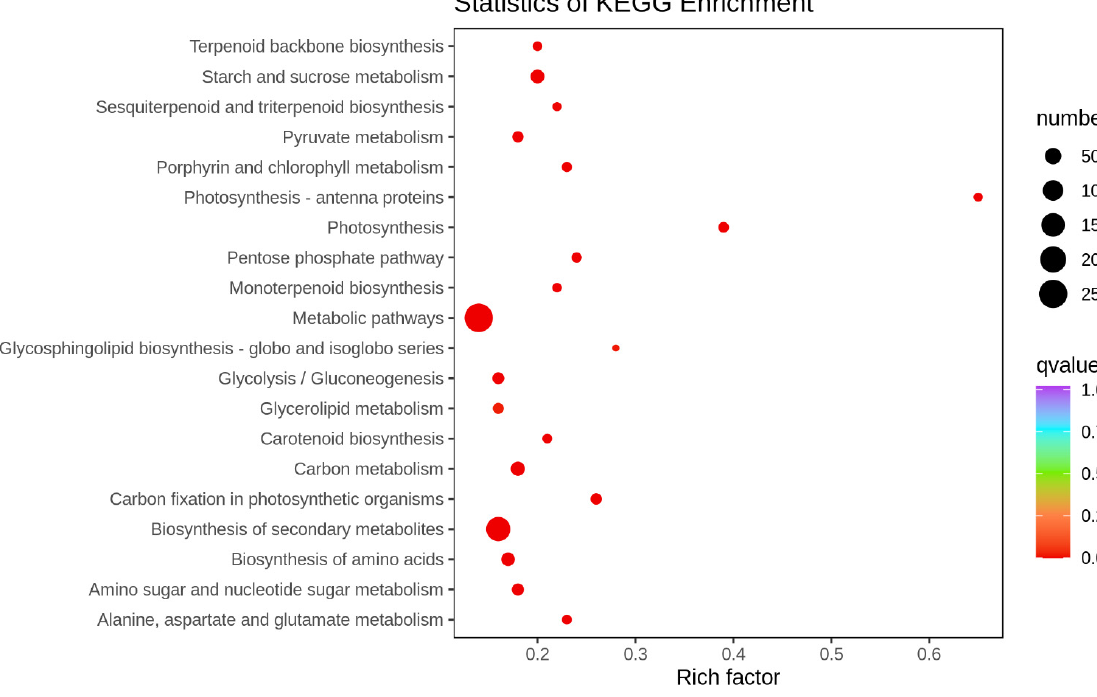
Figure 5. Top 20 enriched KEGG pathways in a comparison of CG and DS transcriptomes.